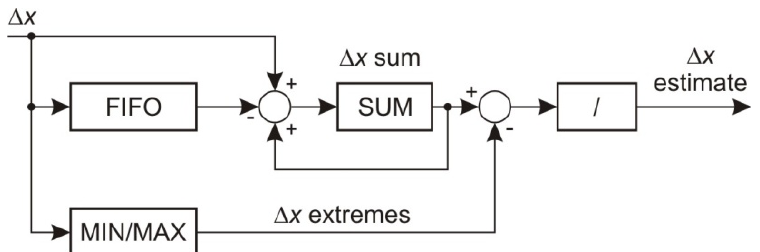
Figure 4. The structure of x -coordinate